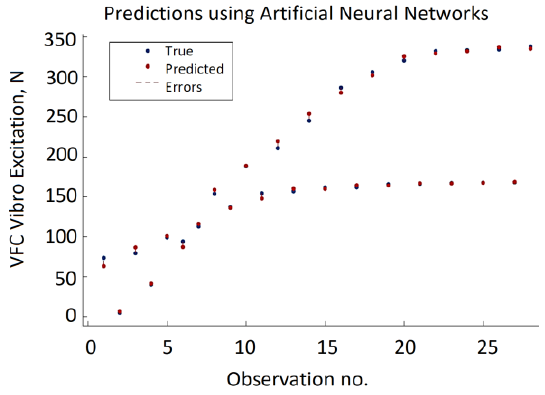
Figure 14. Testing data results of the ANN model.